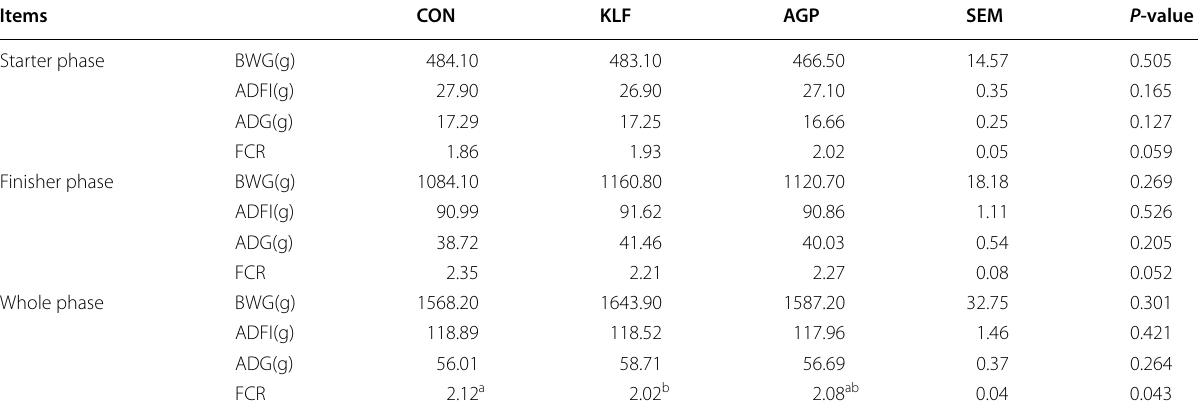
Table 2 Effects of kudzu-leaf flavonoids supplement on the growth performances of Yellow-feathered chicken